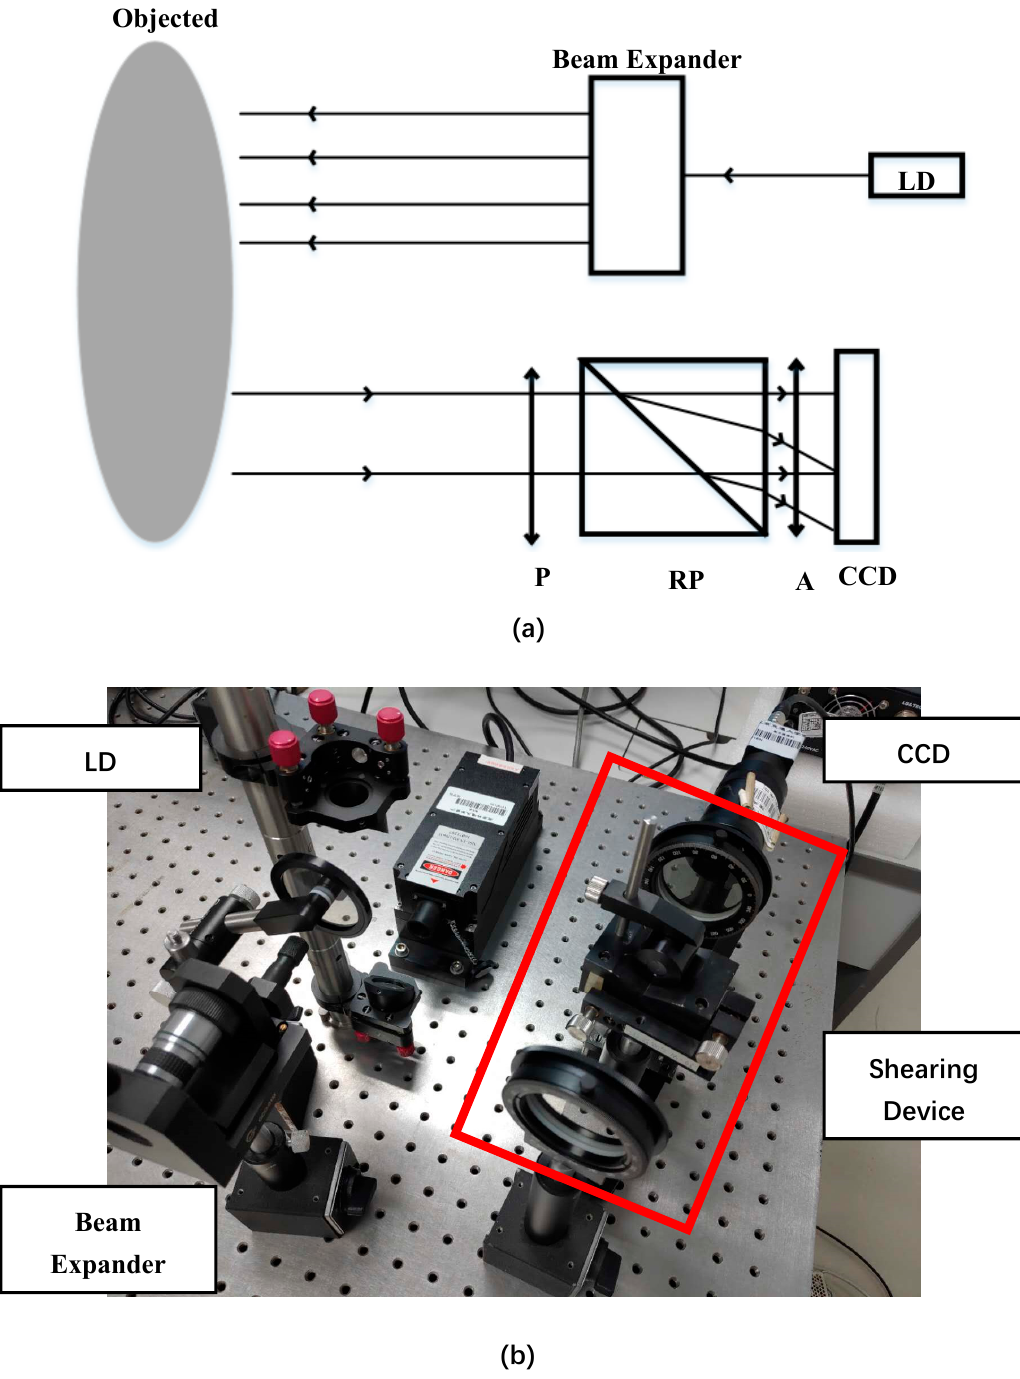
Figure 5. ( a ) The measurement scheme and ( b ) the setup of the measurement system.